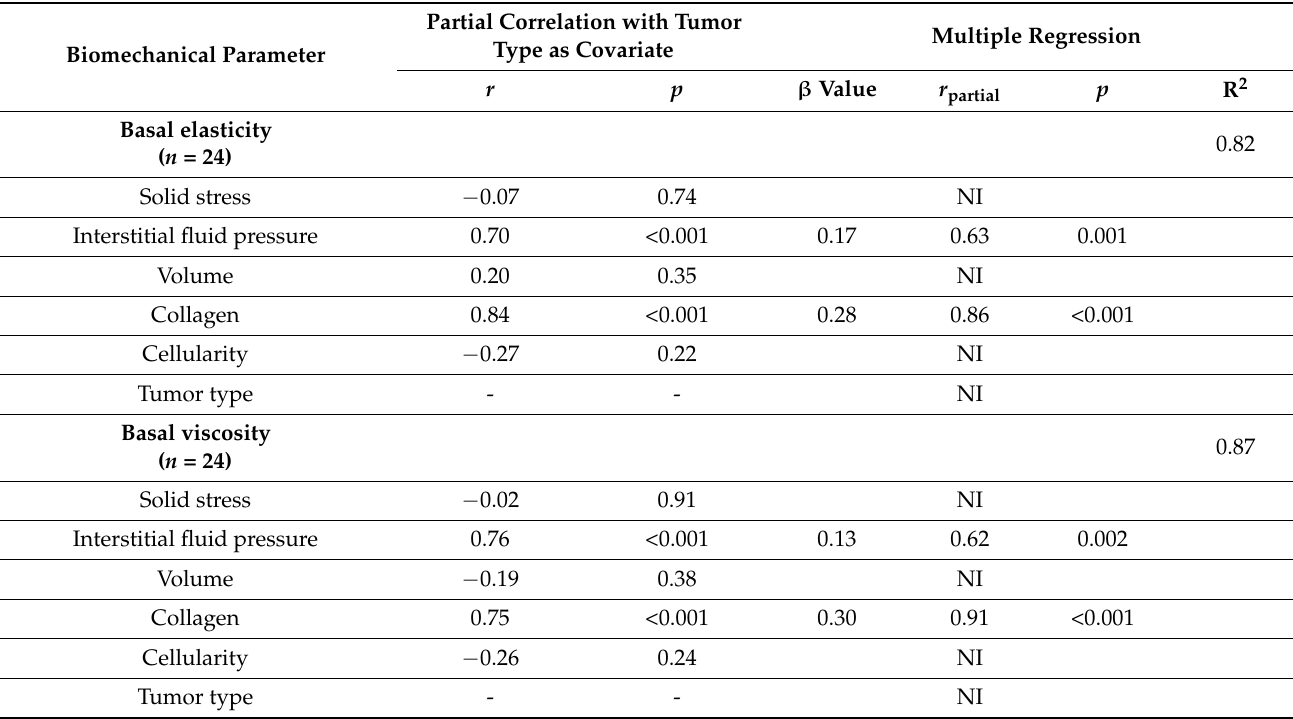
Figure 2. Comparison of digital histological features between hepatocellular carcinomas and cholangiocarcinomas. Repre- sentative picrosirius red pictures to quantify collagen ( A ) and nucleus stained pictures ( C ) to quantify cellularity. Hepatocel- lular carcinomas have significantly lower collagen content and higher cellularity than cholangiocarcinomas ( p < 0.001 and p = 0.005, respectively) ( B , D ). Table 1. Associations between mechanical parameters determined by MR elastography and tumor pressure, volume, and histological features.